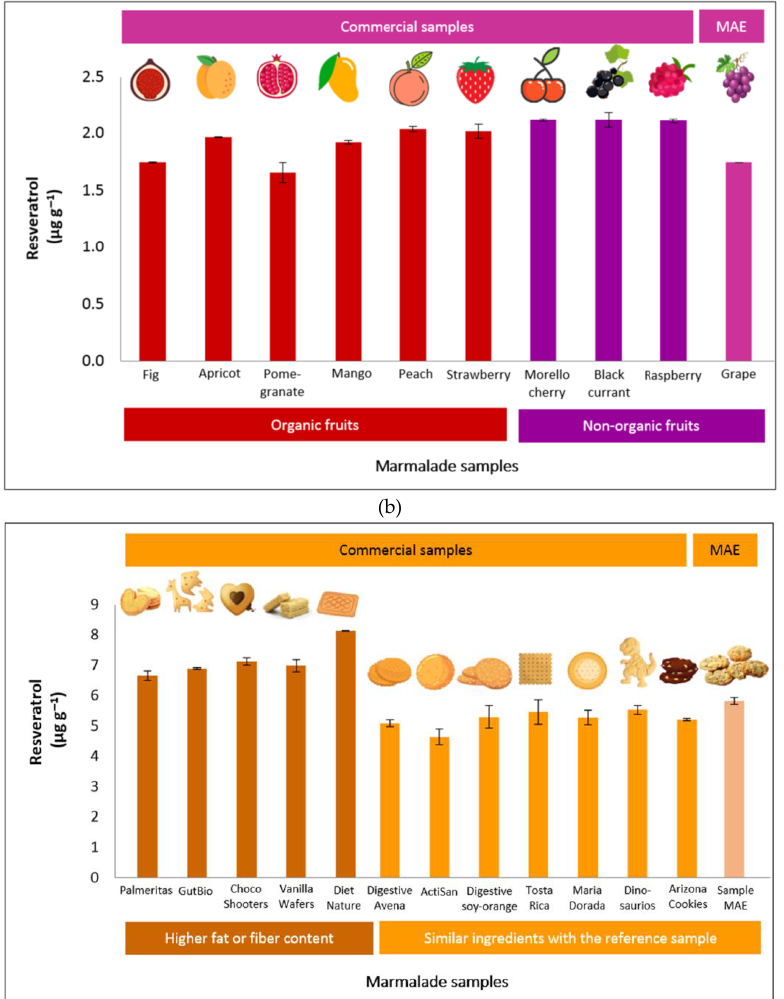
Figure 5. Quantification of resveratrol in commercial products ( a ) marmalade and ( b )